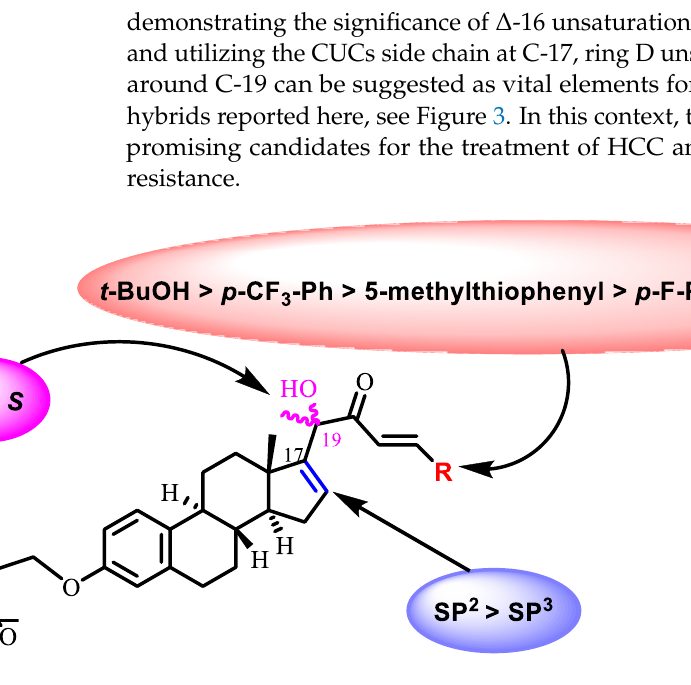
Figure 3. SAR of target compounds.